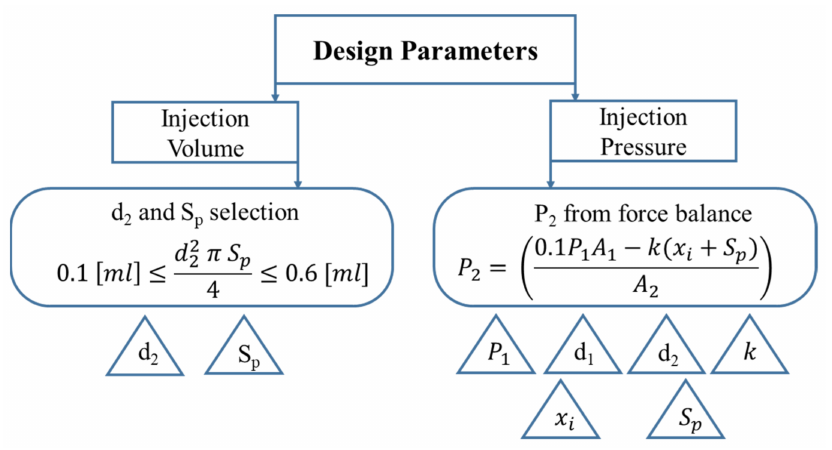
Figure 5. Hierarchy for NFJIS design parameter